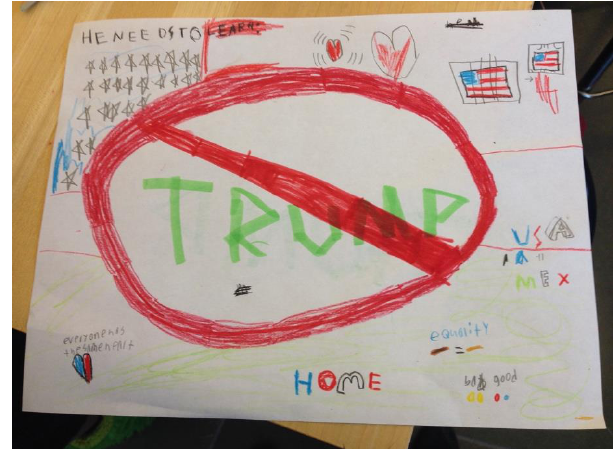
FIGURE 3. CHILD’S PROTEST SIGN